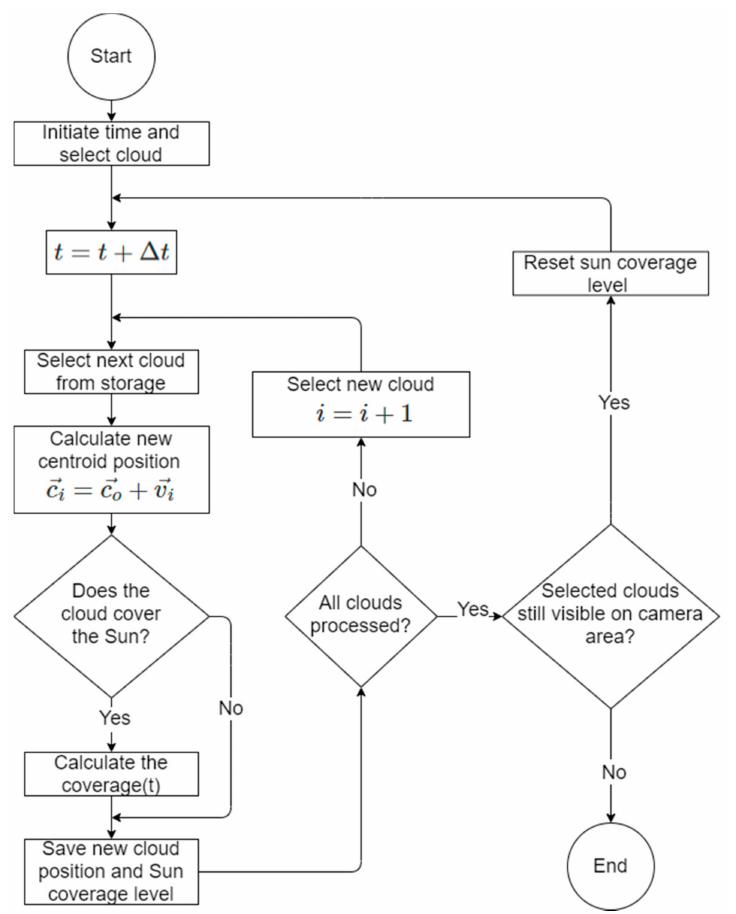
Figure 10. Sun coverage estimation algorithm flow